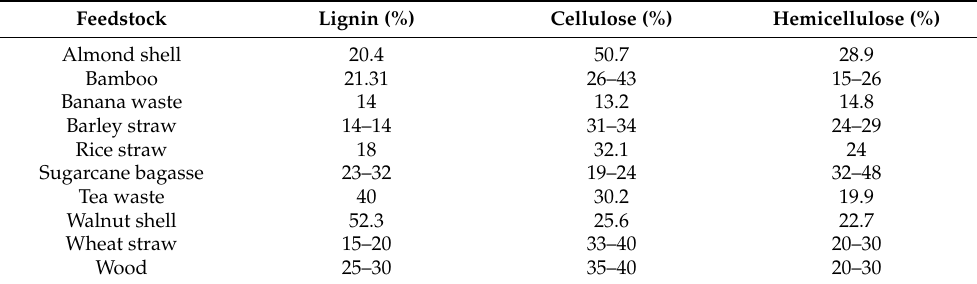
Table 1. The biochemical composition of some agriculture lignocellulosic biomasses [14].